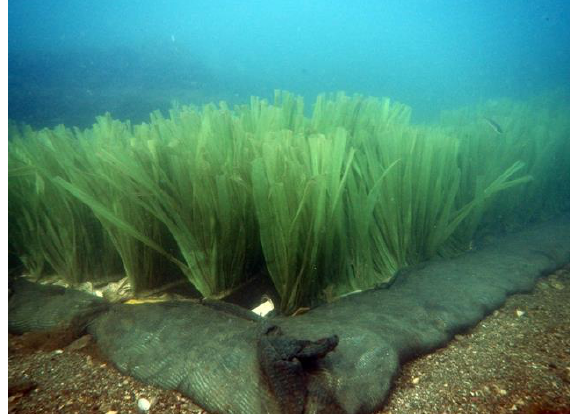
Figure 6. An artificial seagrass mat on the seabed. The plastic fronds work in two ways; catch sediment suspended in the water column and creat a burial mount or if there is no sediment transport they can slow down water